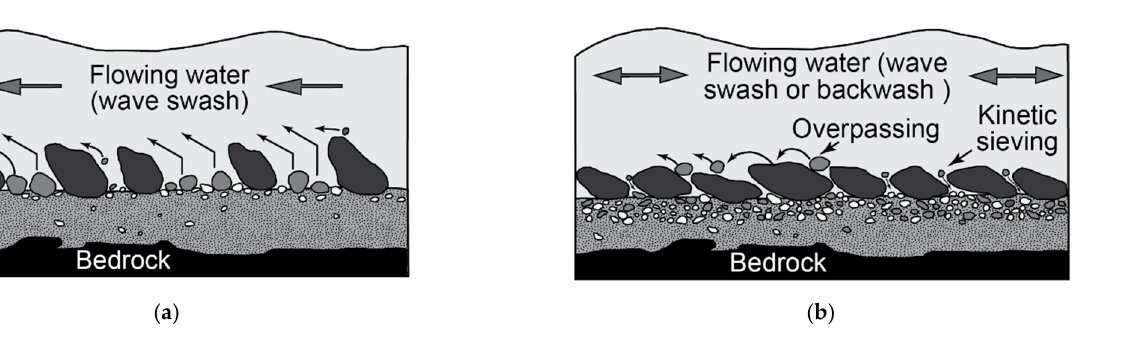
Figure 1. Conceptual models for the development of armoring on gravel or mixed sand-gravel beaches. ( a ) Segregation and armoring caused by a differentiation by clast shape and size during wave swash, followed by inverse grading due to progressively declining flow driven by infiltration of backwash (modified from Hayes and Michel [5]. ( b ) Armoring caused by storm wave swash flow over a mixed beach composed of clasts with different thresholds for movement (modified from Hayes and Michel [2,15]). In this case, intermediate-sized and some small clasts are removed from the upper bed of the intertidal beach by wave swash, whereas some small clasts are shielded by clasts which are too large to be moved. After initial armoring, further protection is driven by overpassing (intermediate-sized clasts bounce over armor and continue up-beach) and kinetic sieving (filtering of smaller particles into the interstices of larger particles) during both wave swash and backwash. Armoring may be a product of both models.